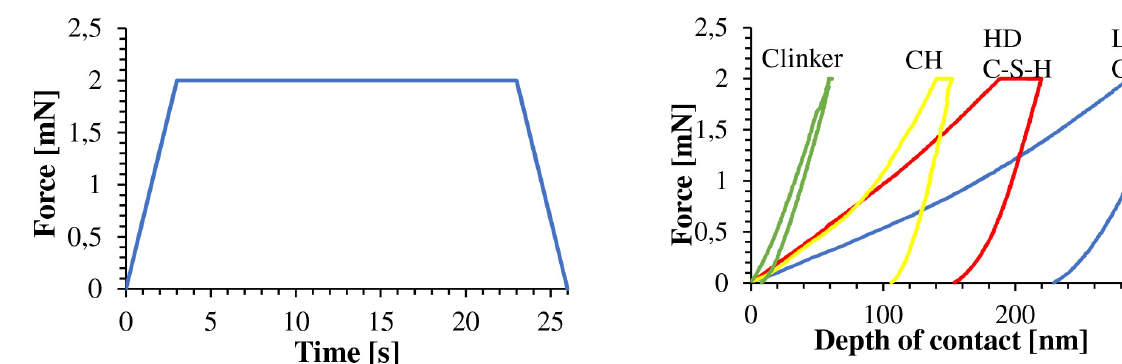
Figure 5. Indentation curves.